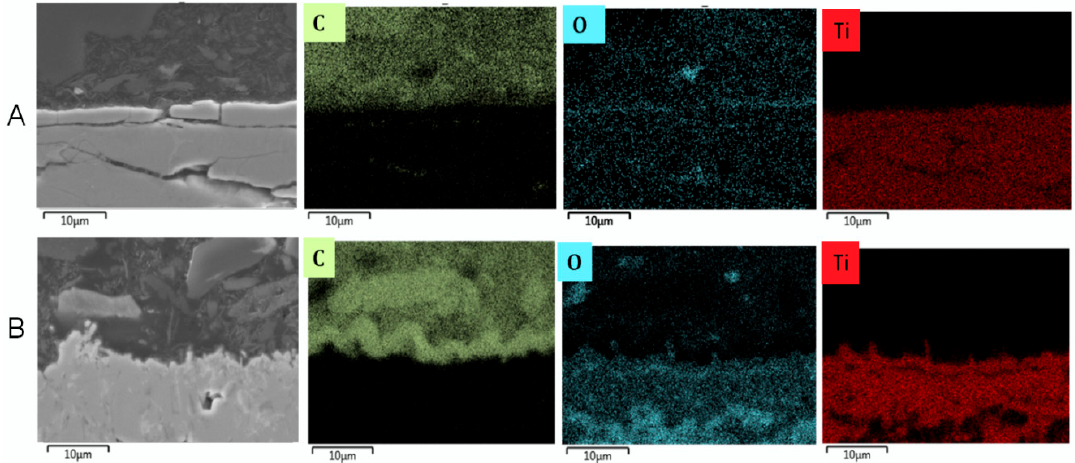
Figure 10. SEM and EDX cross-sectional analysis of coked Ti–base alloy samples after pretreatment and seven coking/decoking cycles followed by a 6 h coking. Accelerating Voltage: 15 kV. A refers to pretreatment A and B to pretreatment B.